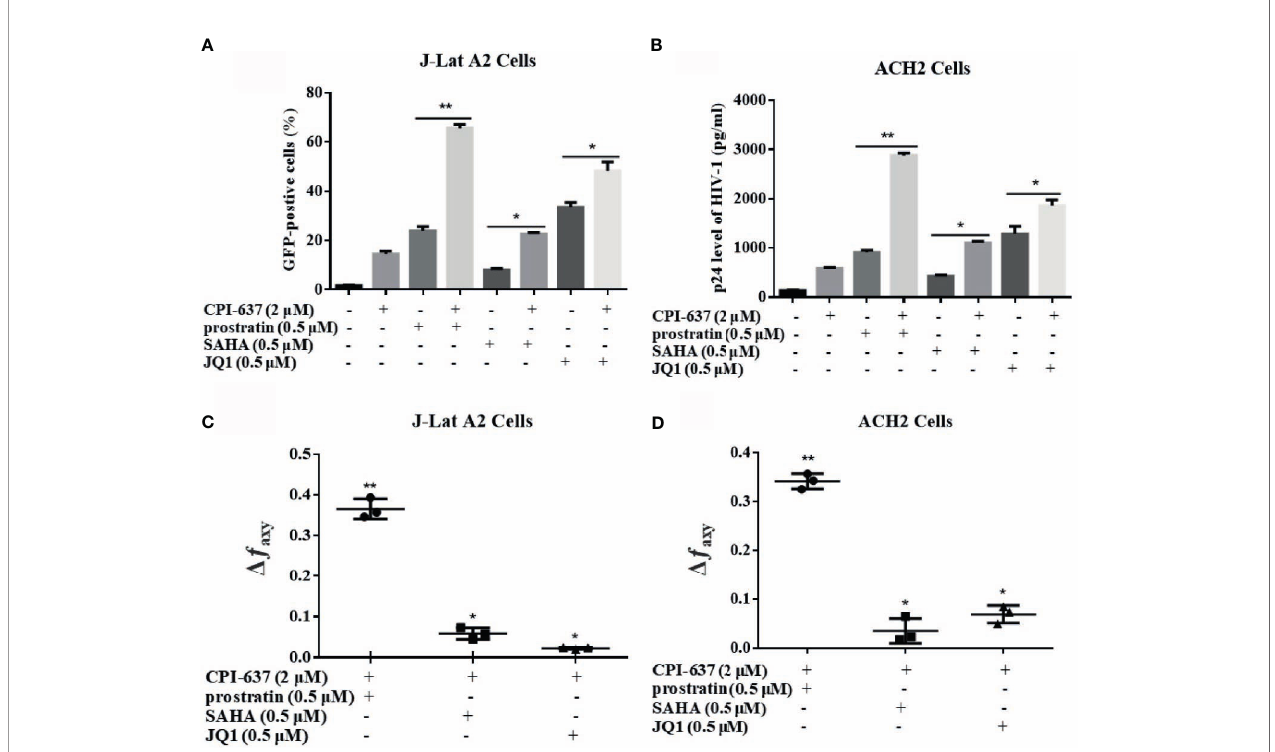
FIGURE 6 | CPI-637 synergistically reactivates latent HIV-1 with conventional candidate LRAs. J-Lat A2 cells (A) and ACH2 cells (B) were treated with CPI-637 (2 m M), SAHA (0.5 m M), JQ1 (0.5 m M), prostratin (0.5 m M) or their combinations for 48 h. The percentage of GFP-positive cells within the entire population was measured by fl ow cytometry and HIV p24 antigen expressions were analyzed by ELISA. The Bliss independence model was utilized as a way to calculate the synergy of LRA combinations. D f axy > 0 signi fi es synergy, whereas D f axy < 0 signi fi es antagonism. And D f axy = 0 signi fi es additive effect (C, D) . (* p < 0.05 vs combination group, ** p < 0.01 vs combination